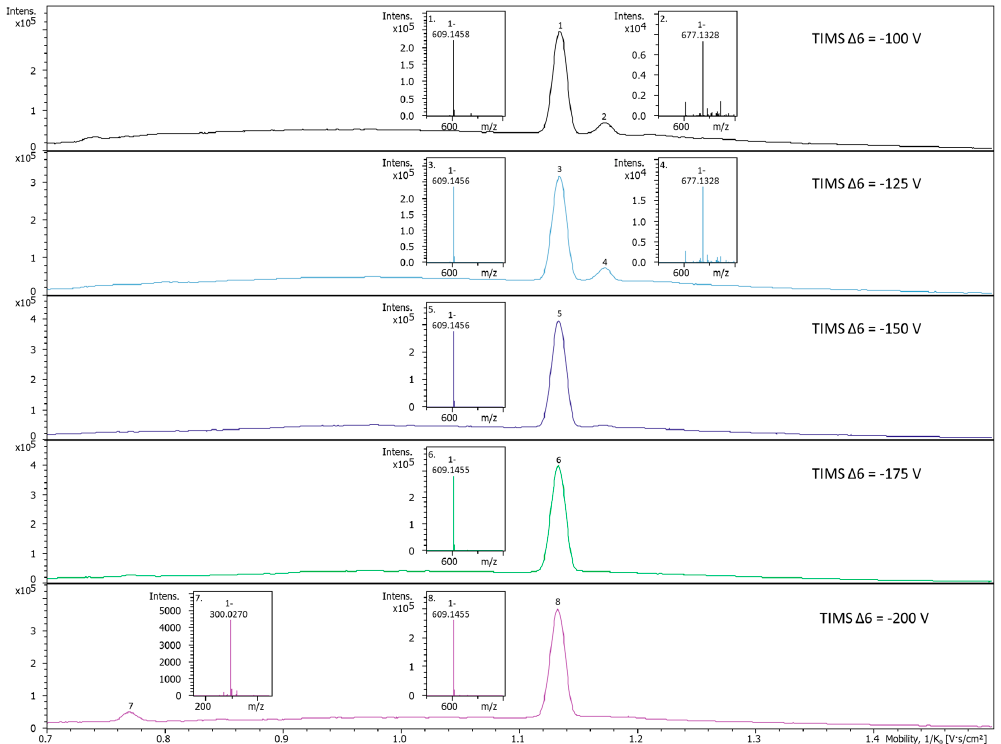
Figure 6. Rutin ion mobility spectra and MS spectra change with increasing transfer voltage parameter (TIMS ∆ 6) voltages. Increases of the TIMS ∆ 6 voltage cause changes to the ion mobility spectra of rutin. The 677 m / z adduct is no longer present when the TIMS ∆ 6 is increased to − 175 V, and at − 200 V, fragmentation of rutin occurs and a new aglycone ion at 300 m / z appears. This illustrates that increases in the TIMS ∆ 6 voltage can create collisions within the TIMS tunnel before TIMS analysis. This can be useful for the identification of adducts, reduction in space charge e ff ects, and / or fragmentation of compounds for a three-step fragmentation method using TIMS ∆ 6, in-source CID, and collision cell